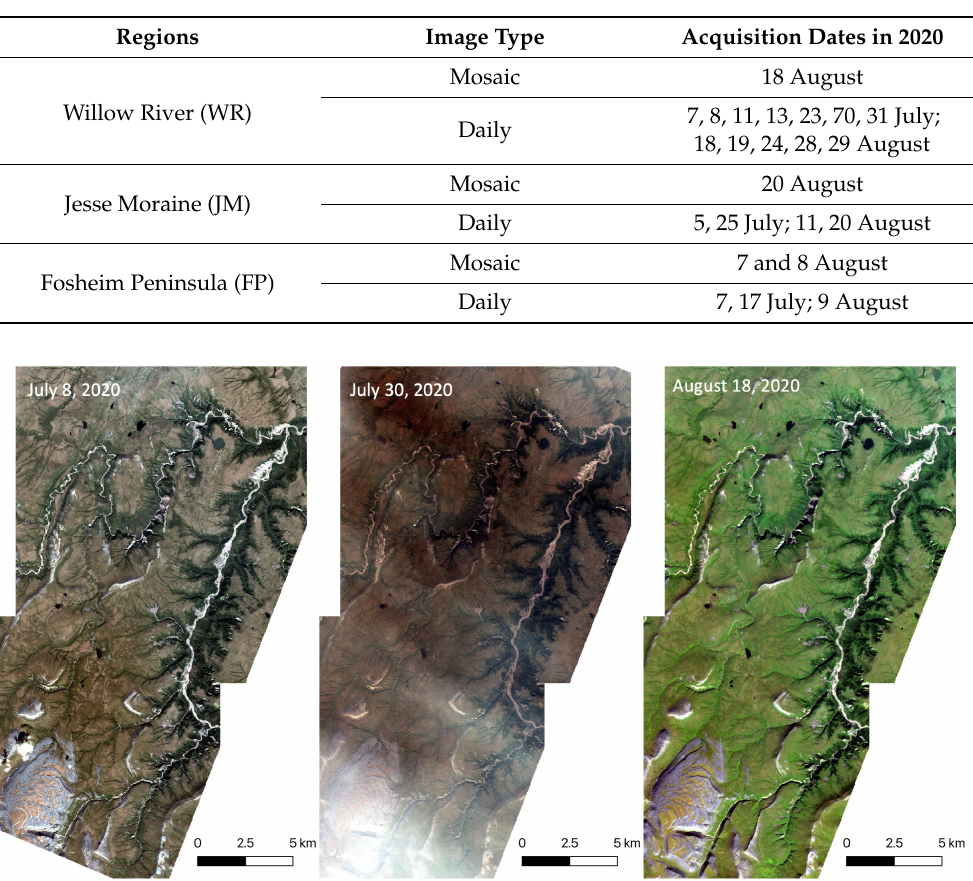
Figure 2. PlanetScope images (RGB) covering the Willow River (WR) demonstrating variable summer reflectance due to different illumination conditions, haze, and cloud